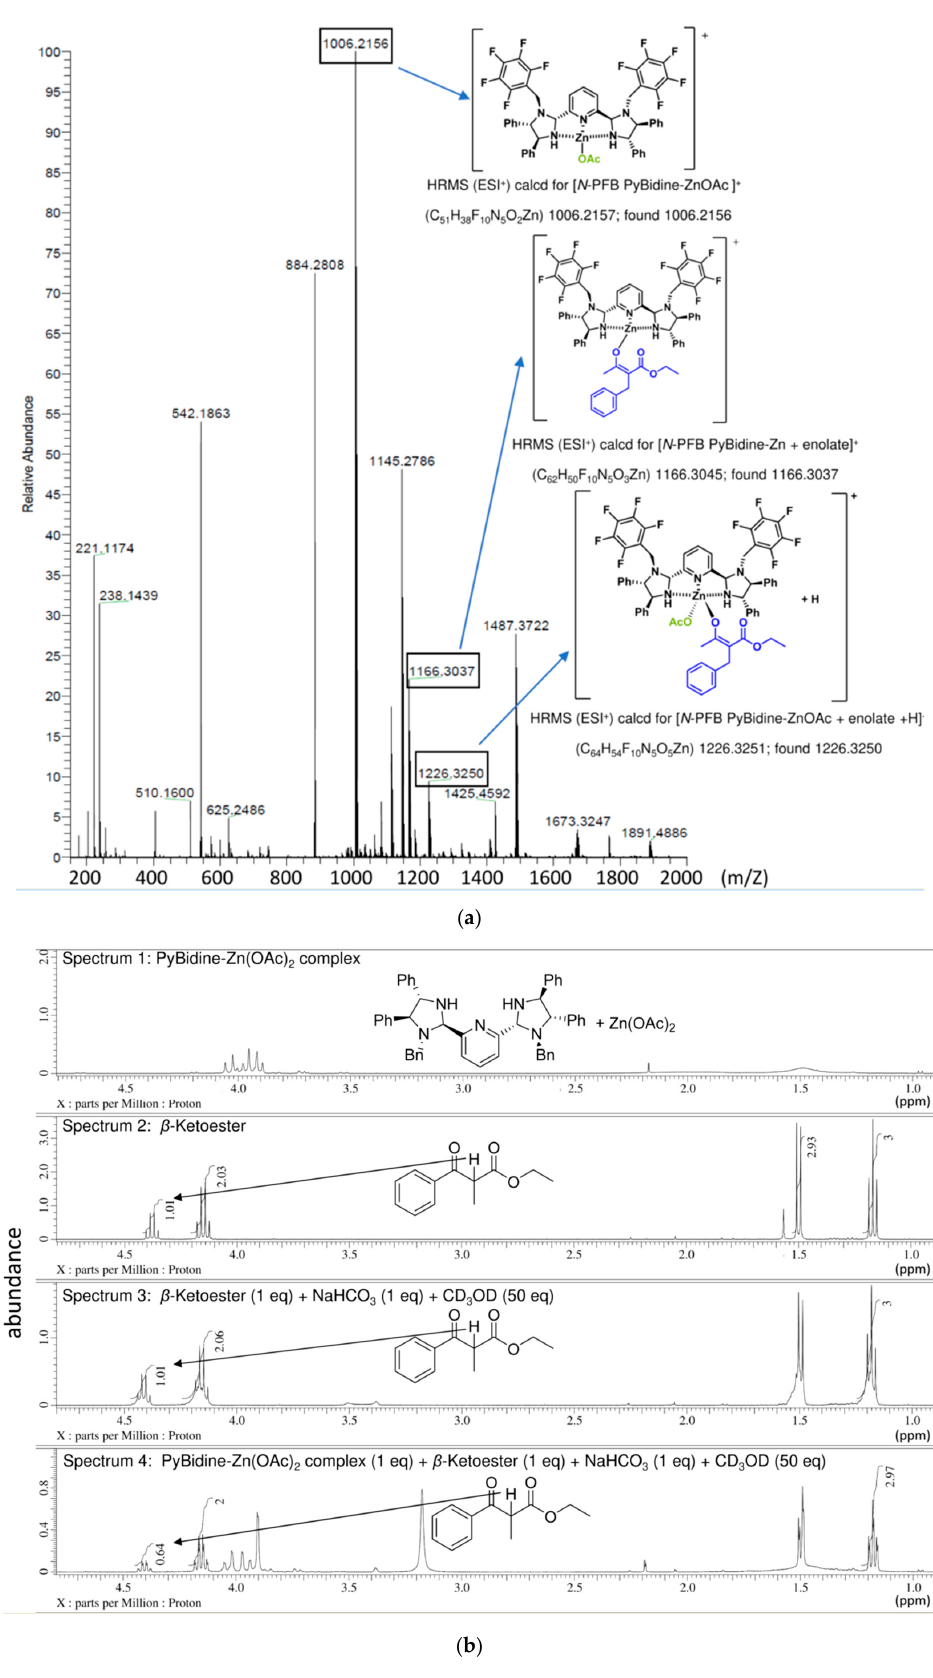
Figure 2. ( a ) ESI-MS analysis and ( b ) 1 H-NMR study in CDCl 3.